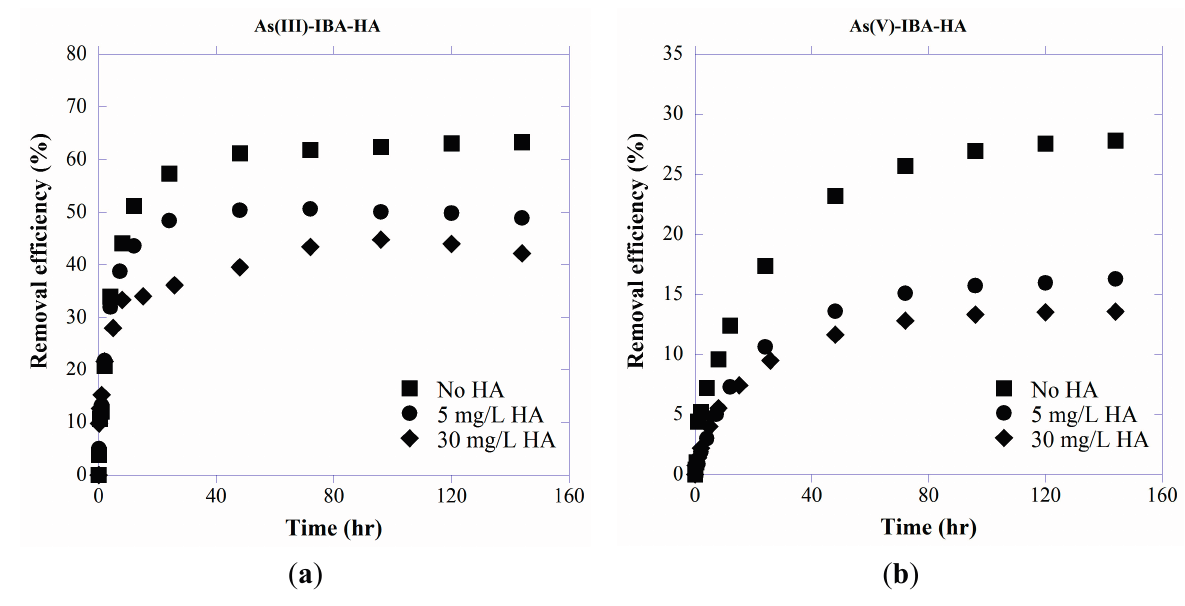
Figure 2. Effect of HA concentrations on removal efficiency of ( a ) As(III) and ( b ) As(V) by IBA with initial As concentration of 5 mg/L at pH